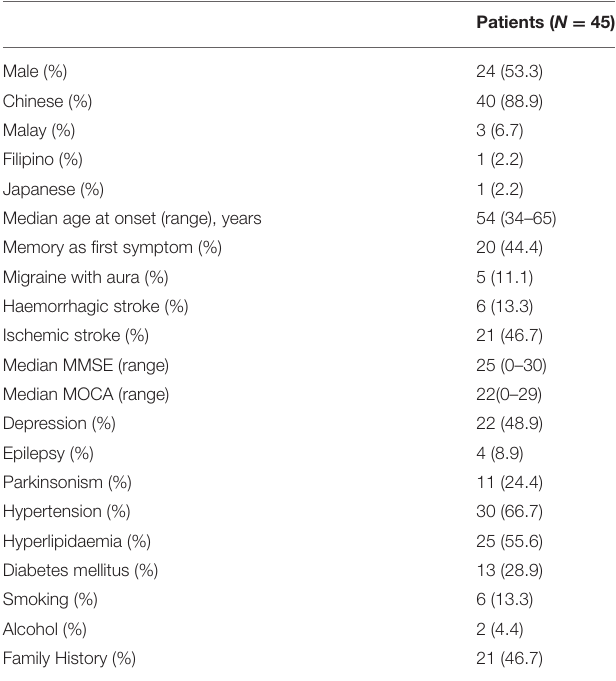
TABLE 1 | Demographics of patients with leukodystrophy on magnetic resonance imaging (MRI).